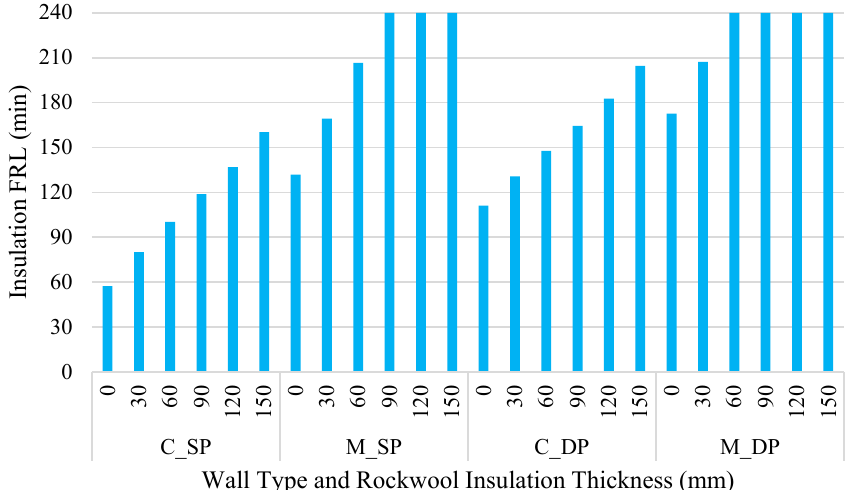
Figure 12. Insulation FRLs of parametric floor systems.